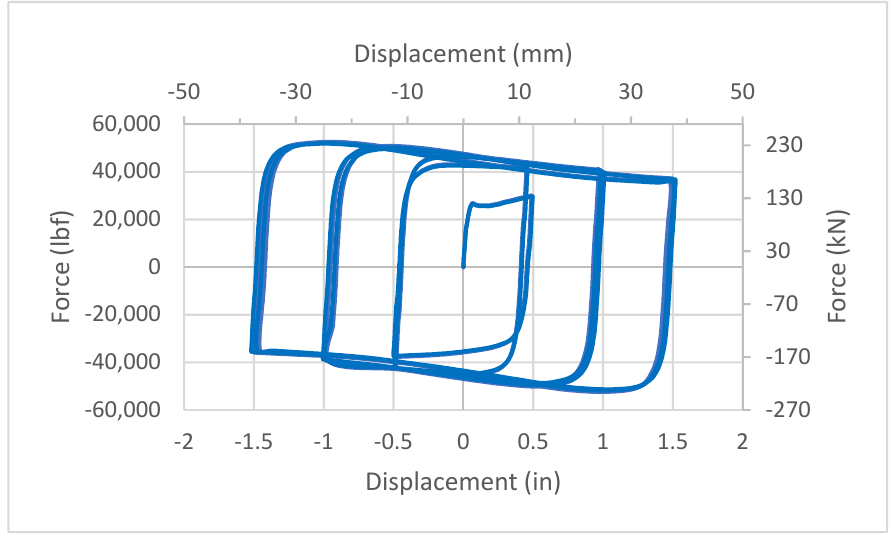
Figure 11. FEM results—horizontal force vs horizontal displacement for MYZ connector.